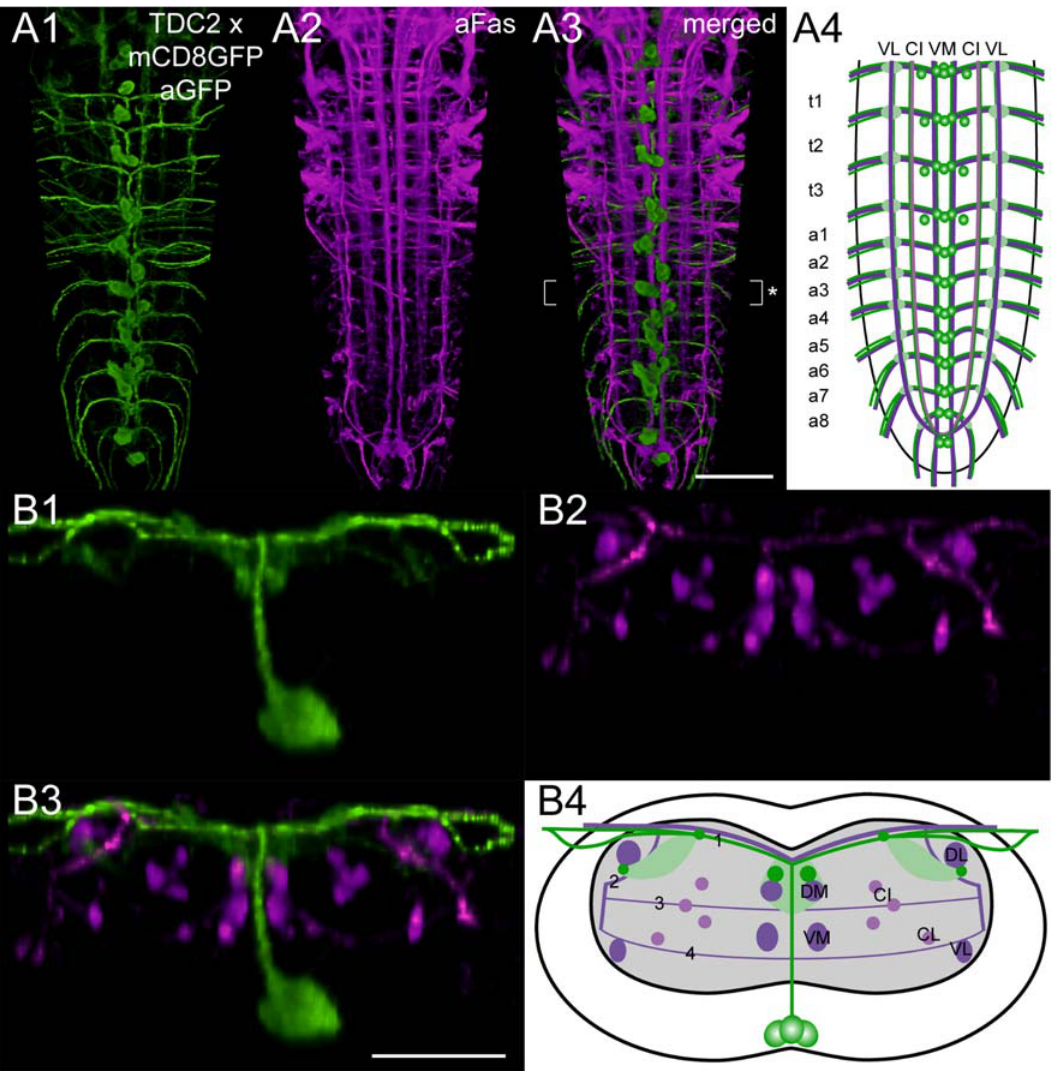
Figure 8. Mapping of Tdc2-gal4 x mCD8GFP expressing neurons. A1) Ventral view of 3D image stacks showing volume-rendered GFP- immunoreactive neurons (green) and A2) Fas2-positive tracts (magenta) in a larva expressing Tdc2-gal4 -driven mCD8GFP. The merged image (A3) served for an idealized schematic representation of Tdc2-gal4 x mCD8GFP expressing neurons in the Fas2 landmark system (A4). B1-3) Corresponding transversal views of the neuromere a3 (* in A3), and B4) the deduced idealized scheme. Note that the idealized scheme A4) includes the pmTDC2 neurons of t1-3 and a1, which often faintly expressed Tdc2-gal4 -driven mCD8GFP. The pmTDC2 neurons, however, always showed strong T b H immunoreactivity (see Fig. S5). Green-shaded areas in the schemes contain a high concentration of GFP-immunoreactive arborizations. Scale bars: 50 m m in A), 25 m m in B).